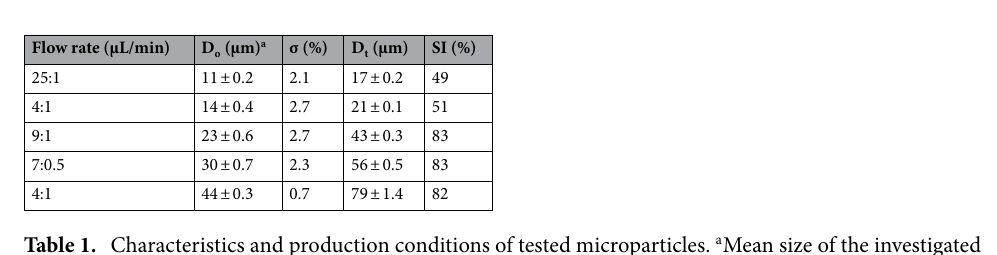
Table 1. Characteristics and production conditions of tested microparticles. a Mean size of the investigated microparticles ± standard deviation (n =